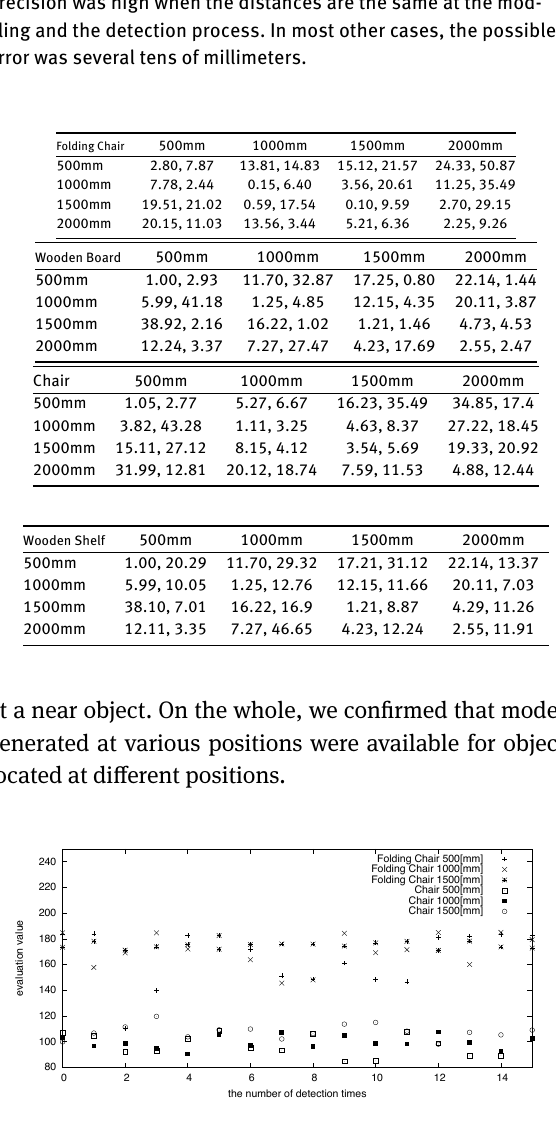
Figure 14: Evaluation values against “Folding Chair” model. “Fold- ing chair” or “Chair” shown in Fig. 9 was a detection target. In any distance, the values of “Folding Chair” were higher than that of